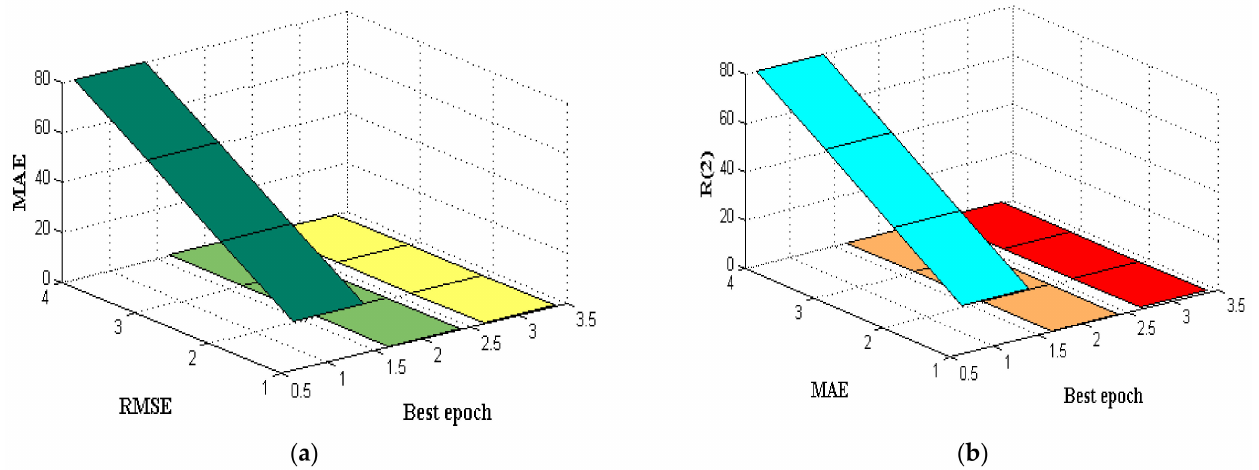
Figure 12. Comparison of error using O 3 /NO 2 /CO/SO 2 ( a ) RMSE vs. MSE. The green and yellow color plots indicate that for every best epoch values the RMSE and MAE values are plotted for existing and proposed method. ( b ) MAE vs. R 2 . The blue, brown and red color plots indicate that for every best epoch values the MAE and R 2 values are plotted for existing and proposed